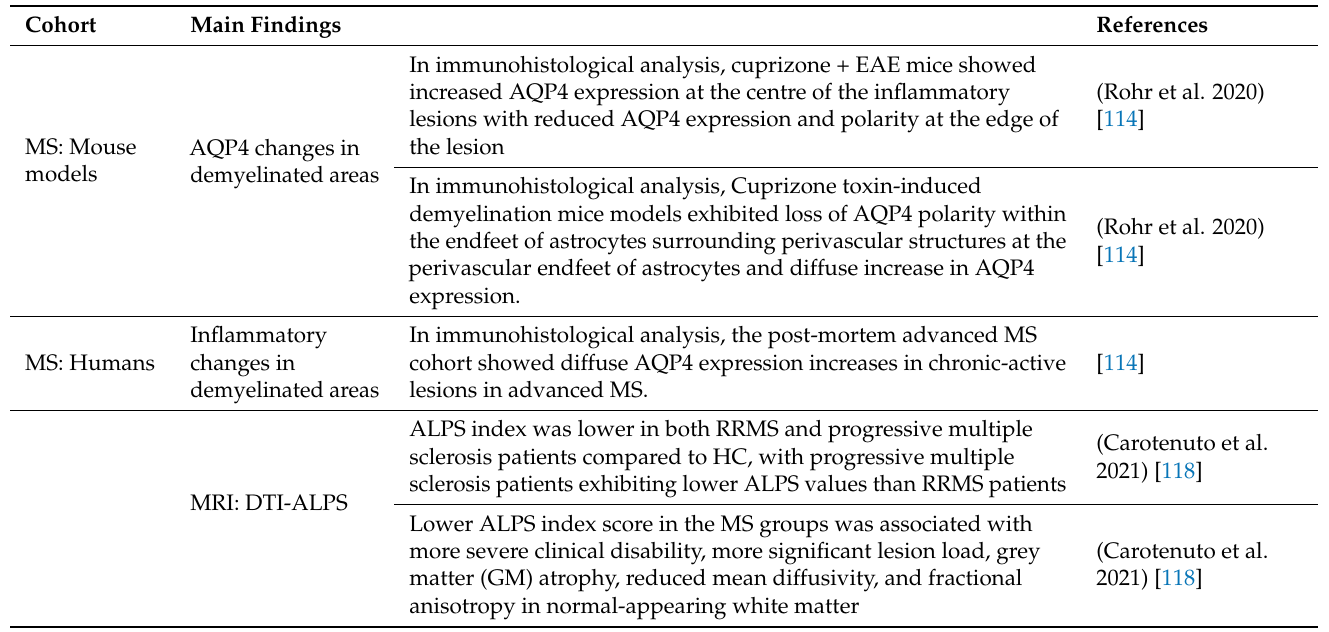
Table 4. Summary of the main findings from studies exploring glymphatic changes in Multiple